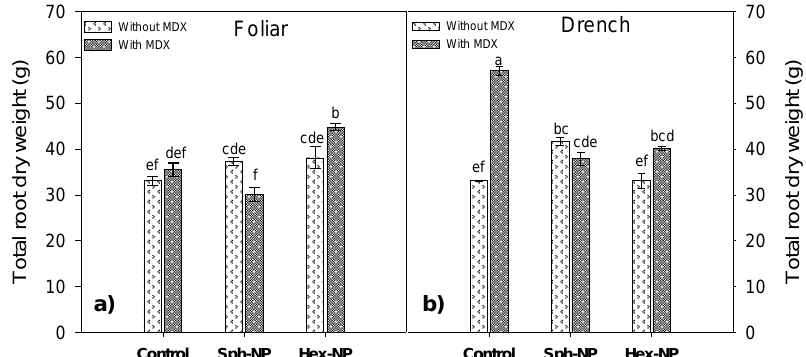
Figure 11. Effect of ZnO-NPs application on root dry weight. ( a ) Morphology*maltodextine (MDX)*foliar application interaction, ( b ) Morphology*MDX*drench application interaction. Bars represent standard error of the mean. Different letters indicate significant differences according to Tukey’s multiple comparison test ( p < 0.05). Sph = spherical, Hex = hexagonal.